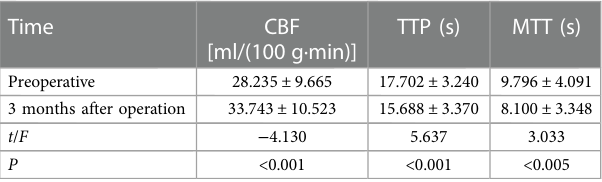
TABLE 1 Comparison of preoperative and postoperative CT perfusion imaging parameters and mRS scores ( X¯ ± S , n =33).